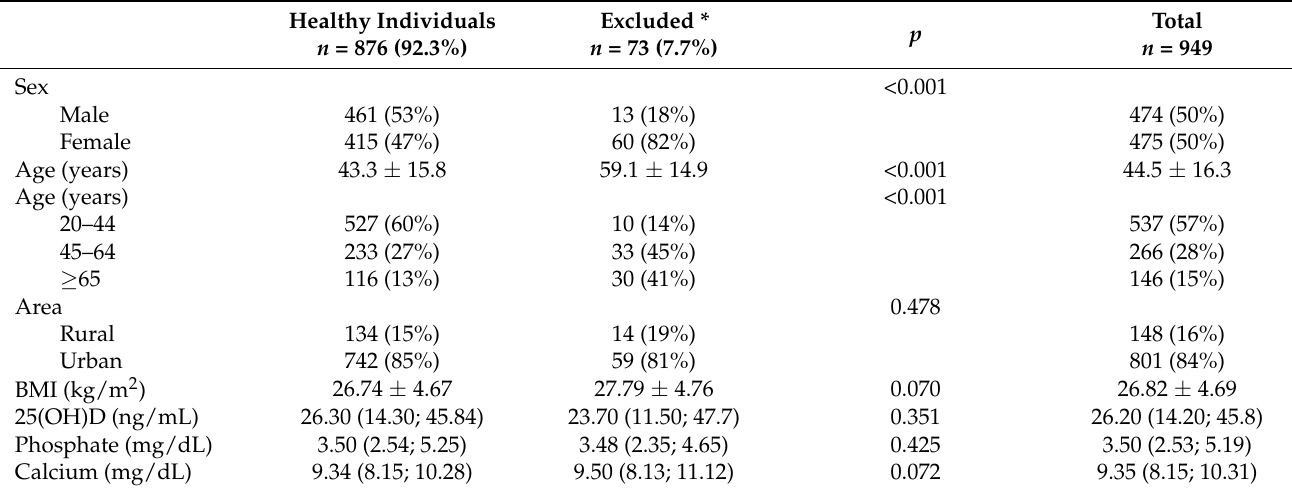
Table 1. Demographic characteristics and levels of VitD, calcium and phosphate in the included (healthy) and excluded